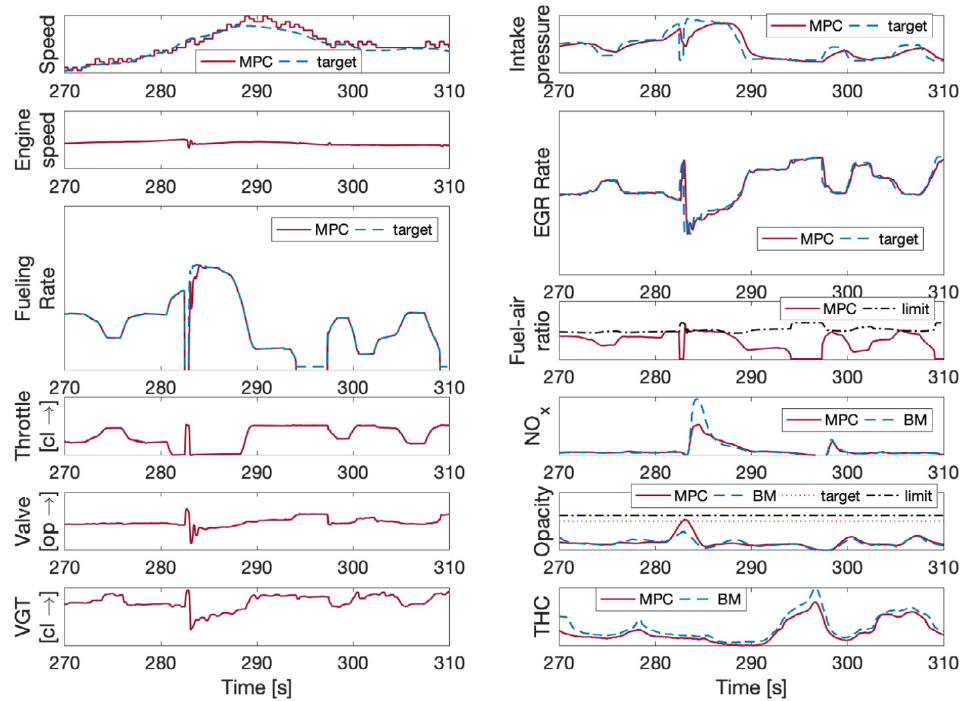
Figure 14. Performance of a nonlinear MPC versus benchmark (BM) production vehicle control strategy to regulate NOx, soot (opacity), and unburned hydrocarbons for a diesel CI engine as part of WLTC drive cycle (Reprinted from [26] with permission of